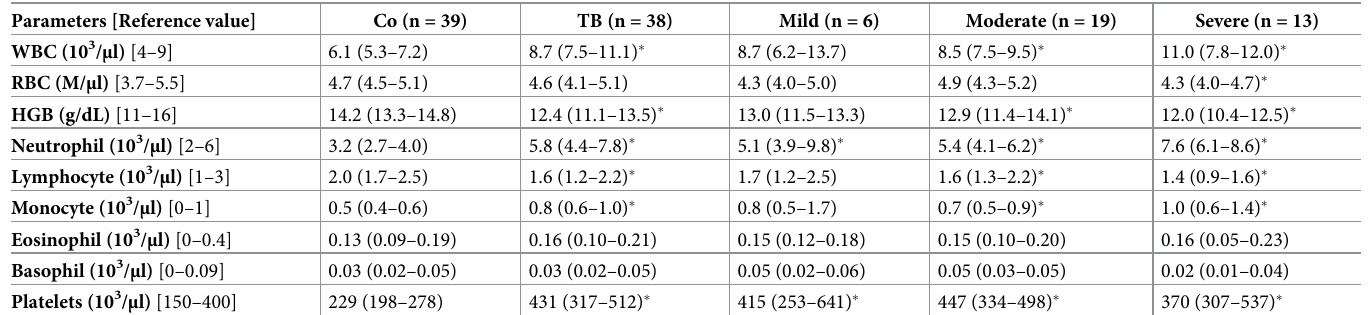
Table 3. Differential blood count.